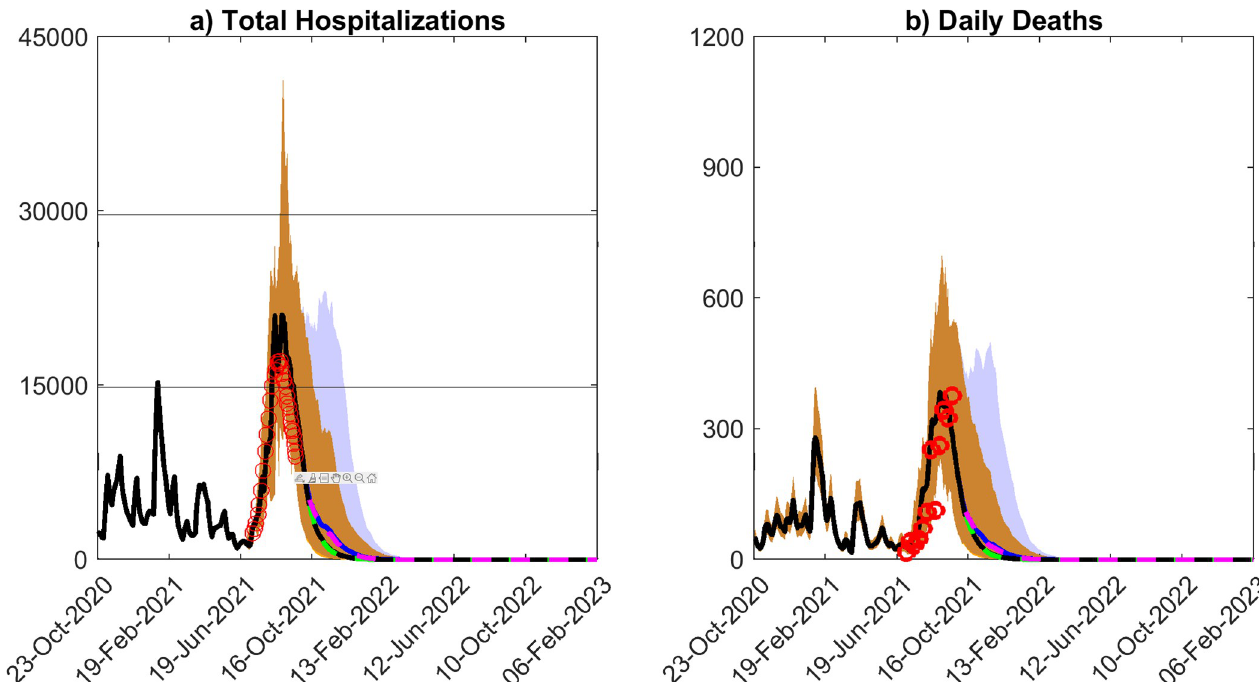
Fig 3. Model predictions of hospitalizations and deaths. Median predictions of a) total hospitalizations and b) daily deaths over time. Several scenarios are shown. Median model predictions given estimates of social distancing measures and daily vaccination rate as of Sept. 24 th 2021 are shown by the solid black curve, while the median model predictions given a full release of social measures is shown in blue. The 90% confidence interval for these two scenarios (social measures estimated on Sept. 24 th 2021, and full release of social measures) are given by the yellow and blue bands, respectively. If vaccination rate is increased by a factor of 1.5x, the median model predictions are shown by the green curve when applying estimates of social measures as of Sept. 24 th 2021 and shown in magenta under a full release of social measures. The daily hospitalization and death data is shown by the red circles.